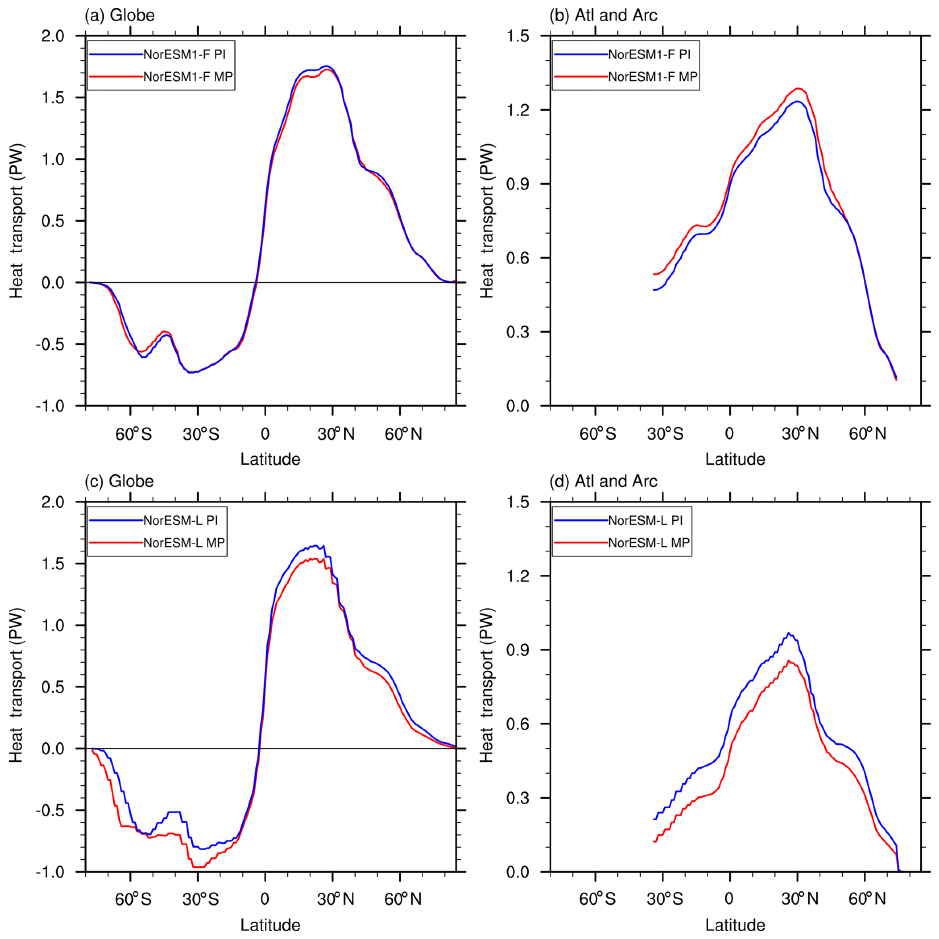
Figure 7. Climatological meridional ocean heat transport (units: PW) derived from the Pliocene (red line) and preindustrial (blue line) experiments according to NorESM1-F (a, b) and NorESM-L (c, d) for the globe (a, c) and Atlantic and Arctic oceans (b, d)